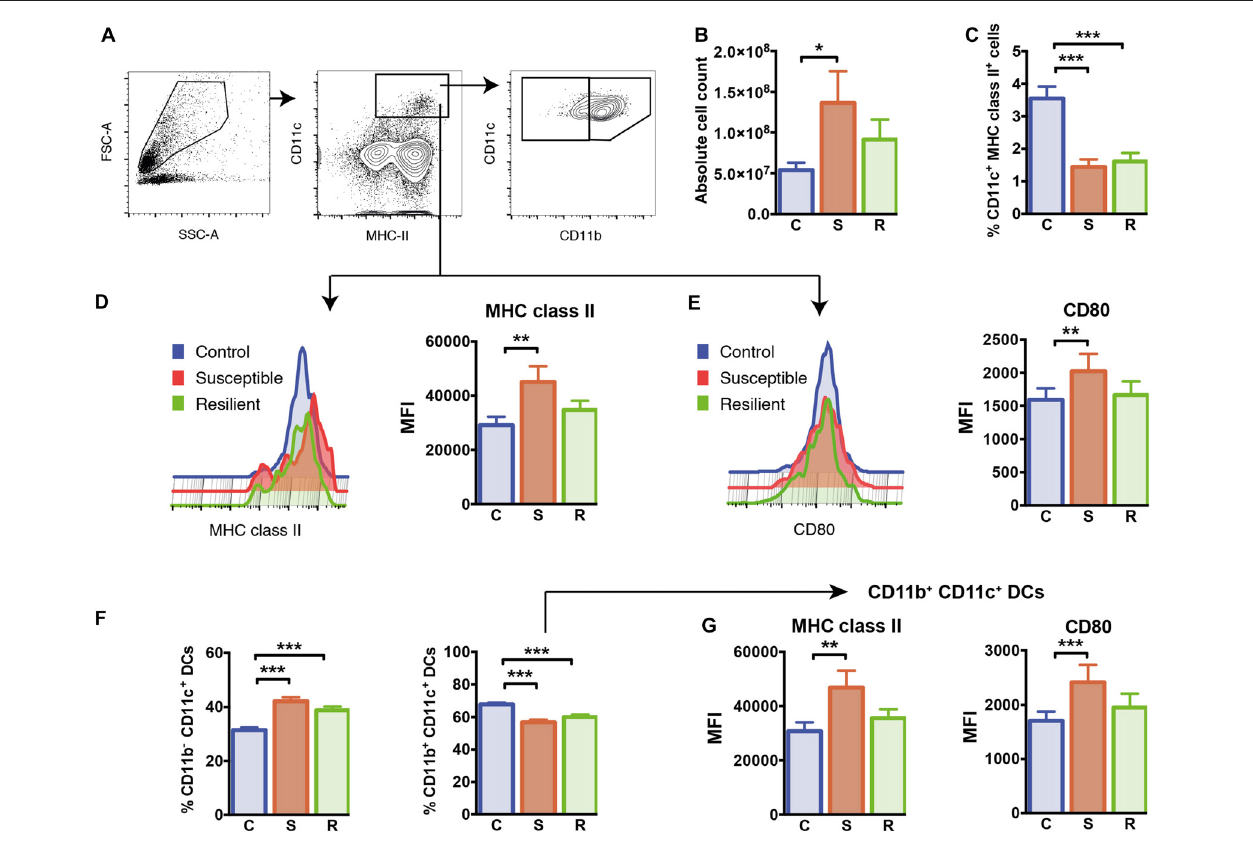
FIGURE 2 | Cellularity and dendritic cells (DCs) in the spleen. (A) Gating of CD11c + MHC class II + DCs and CD11b + /CD11b − DC subsets. (B) The absolute cell numbers isolated from the spleens of experimental mice. (C) Reduced percentages of CD11c + MHC class II + DCs in mice subjected to social defeat. (D) Elevated expression of MHC class II molecules in susceptible mice pregated for CD11c + MHC class II + DCs. (E) Elevated expression of CD80 molecules in susceptible mice pregated for CD11c + MHC class II + DCs. (F) Increased percentages of the CD11b − CD11c + DC subset and decreased percentages of the CD11b + CD11c + DC subset in socially defeated mice. (G) Elevated expression of MHC class II molecules and CD80 molecules in CD11b + CD11c + DCs of susceptible mice. Bar graphs represent mean + SEM. C, control; S, susceptible; R, resilient; MFI, mean fluorescence intensity. Absolute cell count: n C = 16, n S = 15, n R = 15, all other graphs in this Figure: n C = 10, n S = 11, n R = 9. ∗ p < 0.05, ∗∗ p < 0.01, ∗∗∗ p < 0.001.